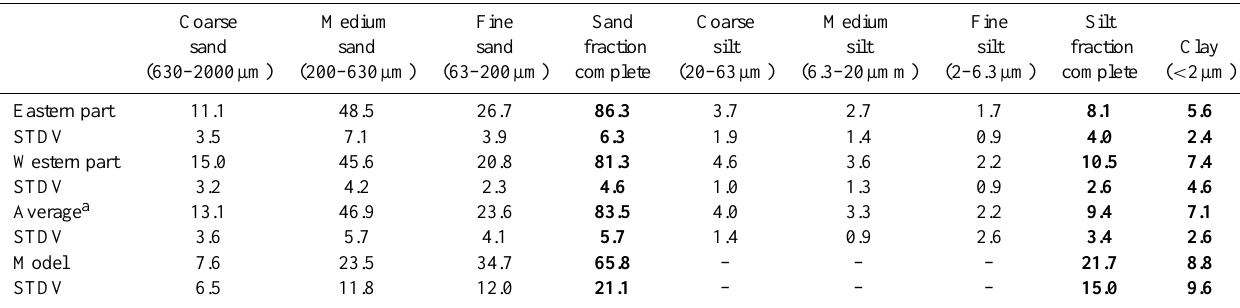
Table 2. Texture data (fine earth fraction particle distributions) from raster soil sampling carried out in 2006, showing the differing values for the eastern and western part of the Chicken Creek catchment. The “eastern” and “western” part comprise only the areas where material was dumped with stacker technology. Courtesy of subproject Z1, SFB/TRR 38. The simulated textures (model) are for the current mixing approach after spatial